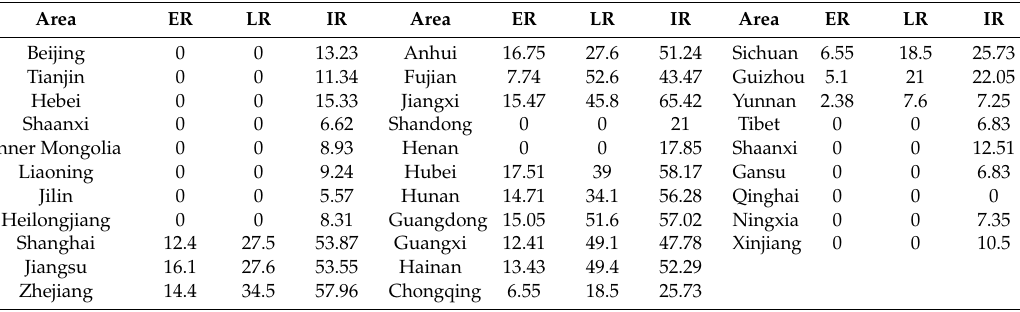
Note: ER = Early Rice, LR = Late Rice, IR = In-Season